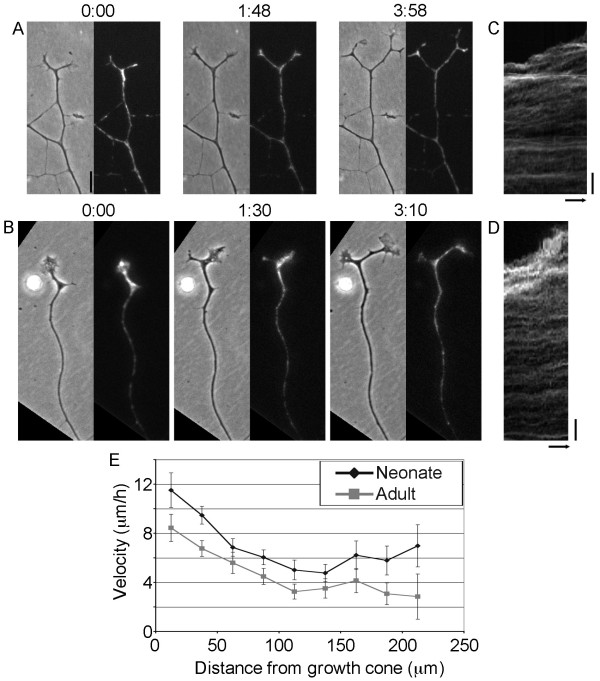
Adult and neonatal sensory neurons elongate by stretching, but at a slower rate than embryonic neurons. Matched phase images of axons and fluorescent images of mitochondria during normal growth of (A.) neonatal rat, and (B.) adult rat sensory neurons. C & D. The kymographs (bar 20 µm, arrow 1 hour) illustrate the advance and spreading of mitochondria along the axons in each type of neuron (see Additional files 1 and 2). E. A quantitative comparison of low velocity mitochondrial transport. The error bars in the graphs are the 95% confidence intervals.